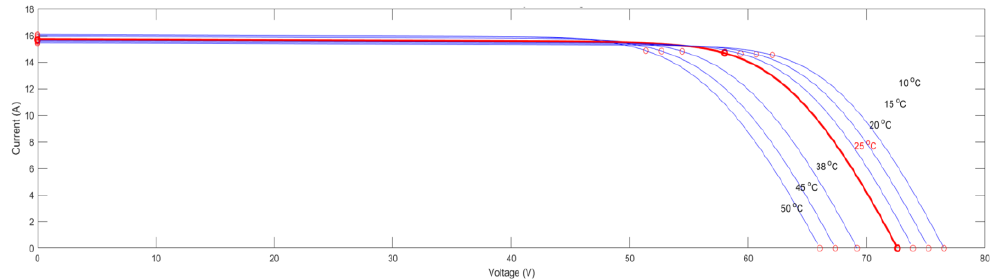
Figure 10. I-V curve simulation of the selected panel in different temperatures.